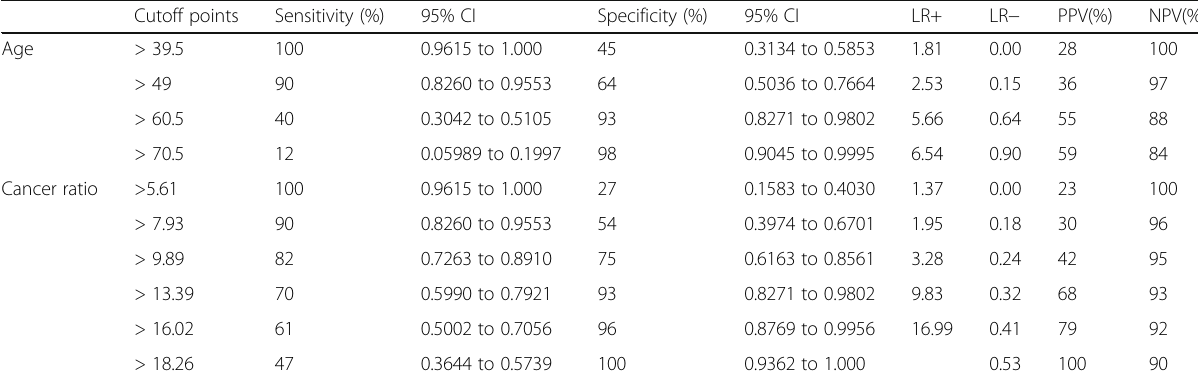
Table 5 Sensitivity, specificity, PPV, and NPV of cancer ratio and age at different cutoff points Cutoff